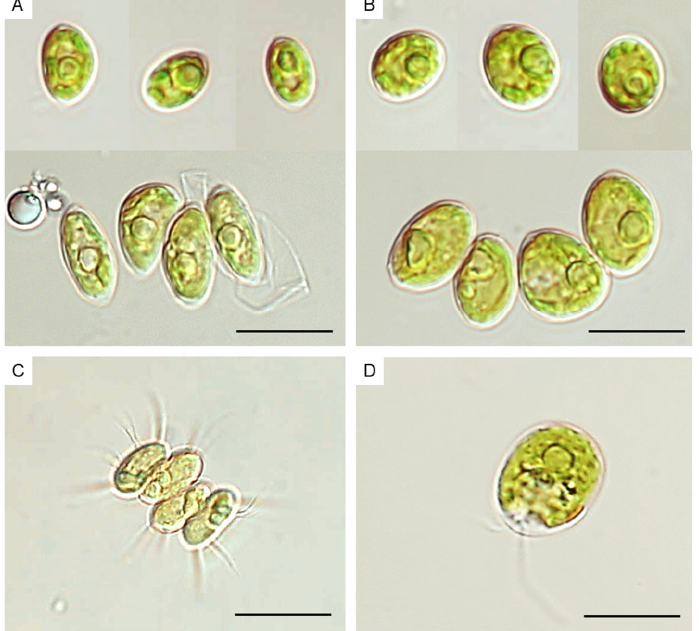
Figure 1. Microalgae from the mixed algal culture. ( A ) Tetradesmus obliquus PNKW01; ( B ) Tetradesmus obliquus PNKW04; ( C ) Desmodesmus subspicatus PNKW02; ( D ) Microglena sp. PNKW03. Scale bars: ( A – C ) 20 µ m; ( D ) 15 µ